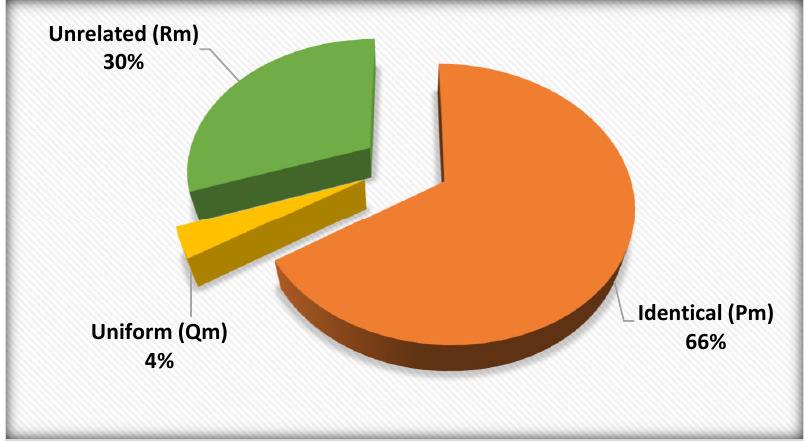
Fig. 8. Percentage distribution of HFS articles according to type of parallel